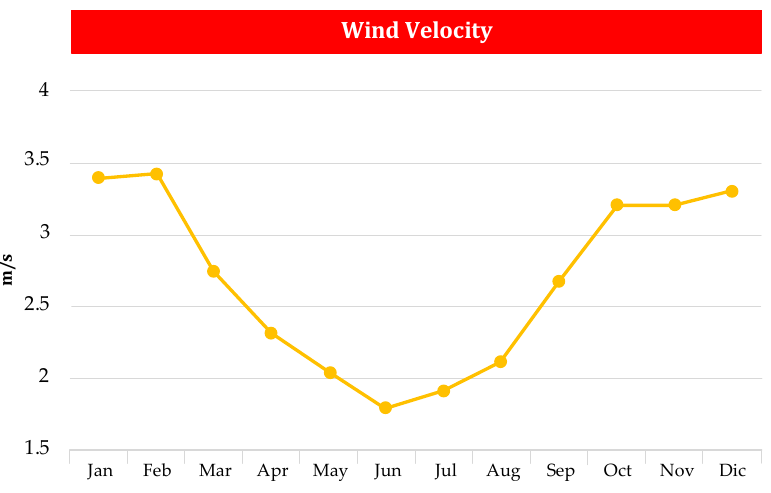
Figure 4. Wind velocity for the county